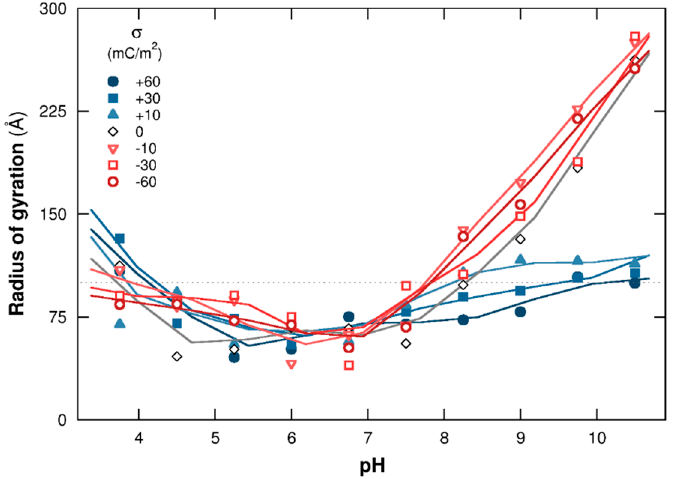
Figure 3. PP mean square radius of gyration as a function of pH. The chain is surrounded by a NP ( σ = − 60 to +60 mC/m 2 ) and monovalent counterions. Cases with negative, neutral, and positive NPs are represented by red open, black open, and blue closed symbols. Dotted line is the NP radius (100 Å). The formation of complexes at pH 7 and above with positively charged NPs and at pH